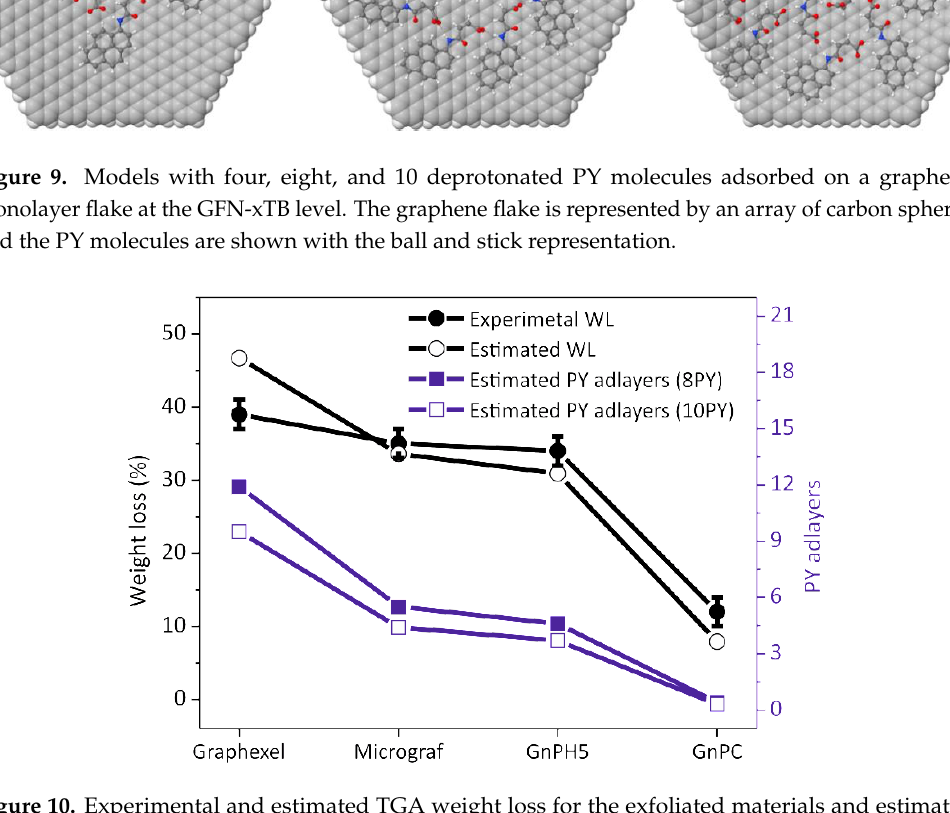
Figure 10. Experimental and estimated TGA weight loss for the exfoliated materials and estimated number of PY number of PY adlayers.